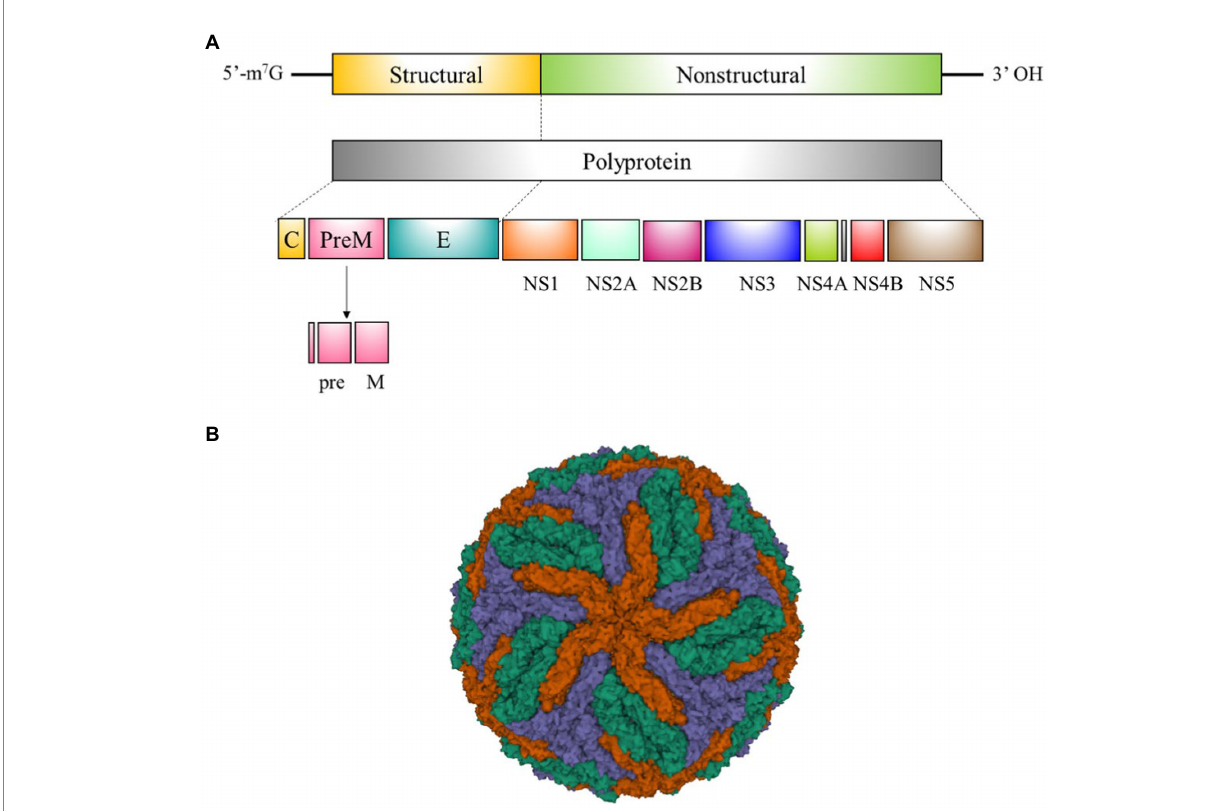
FIGURE 2 Flavivirus genome organization and structure. (A) Schematic representation of flavivirus genome organization and processing of the polypeptide into mature viral proteins. (B) Cryogenic electron microscopy structure of the dengue virus (DENV). E:M heterodimers of the same color are equivalent by icosahedral symmetry. Heterodimers of different colors are quasi-equivalent, with red E:M dimers falling on the icosahedral 5-fold axes, blue on the 3-fold, and green on the 2-fold (PDB 3 J27) (Zhang et al.,